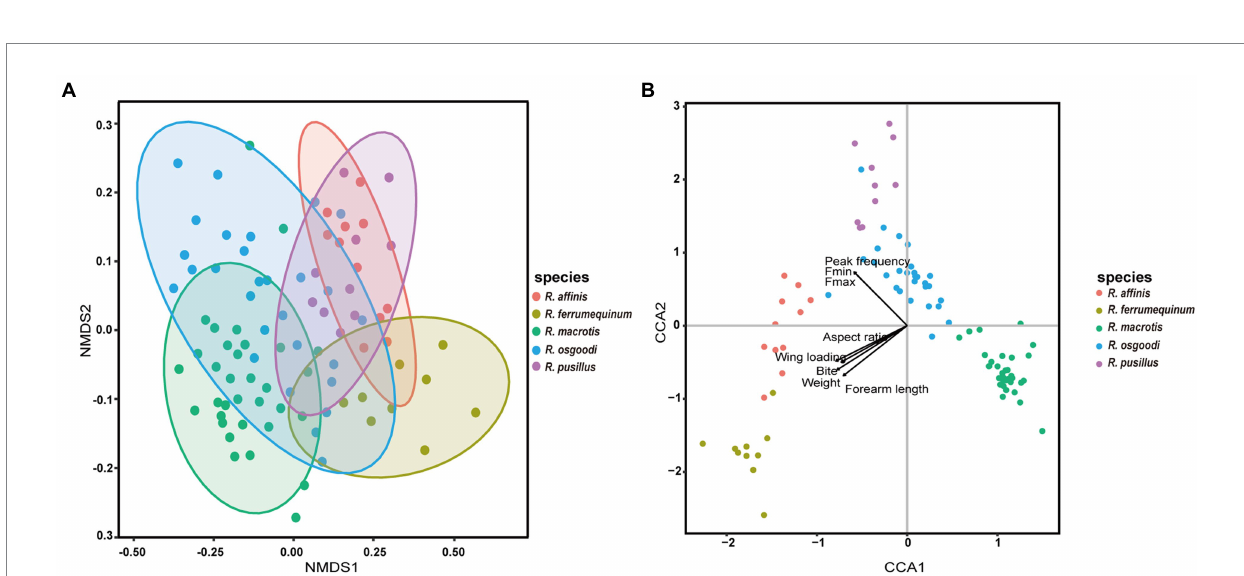
FIGURE 4 (A) Non-metric multidimensional scaling (NMDS) of the diet composition of five bat species based on the operational taxonomic unit (OTU) level. Each point represents an individual. (B) Canonical correspondence analysis (CCA) plot showing the correlation between diet composition and the body size, wing morphology, bite force, and echolocation calls of five bat species. Each point in the graph represents an individual, and the arrows indicate different variables, where the longer the ray, the greater the influence of that variable, and the angles between arrows represent the degree of correlation between them (acute angle: positive correlation; obtuse angle: negative correlation; right angle: no